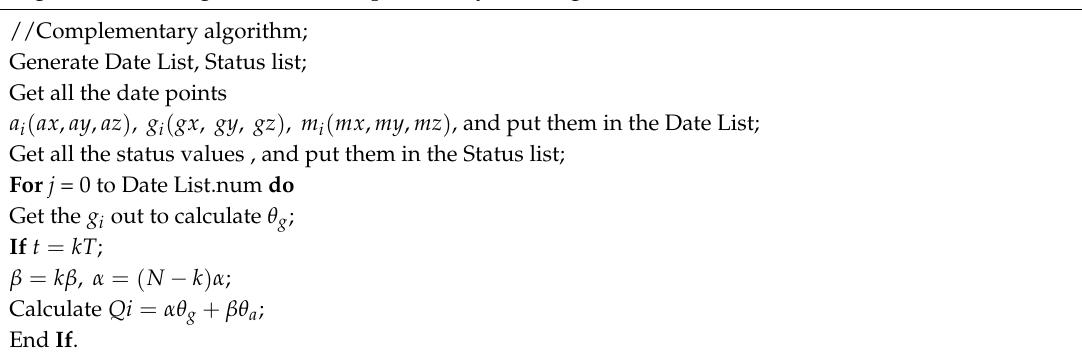
Algorithm: The Algorithm for Complementary